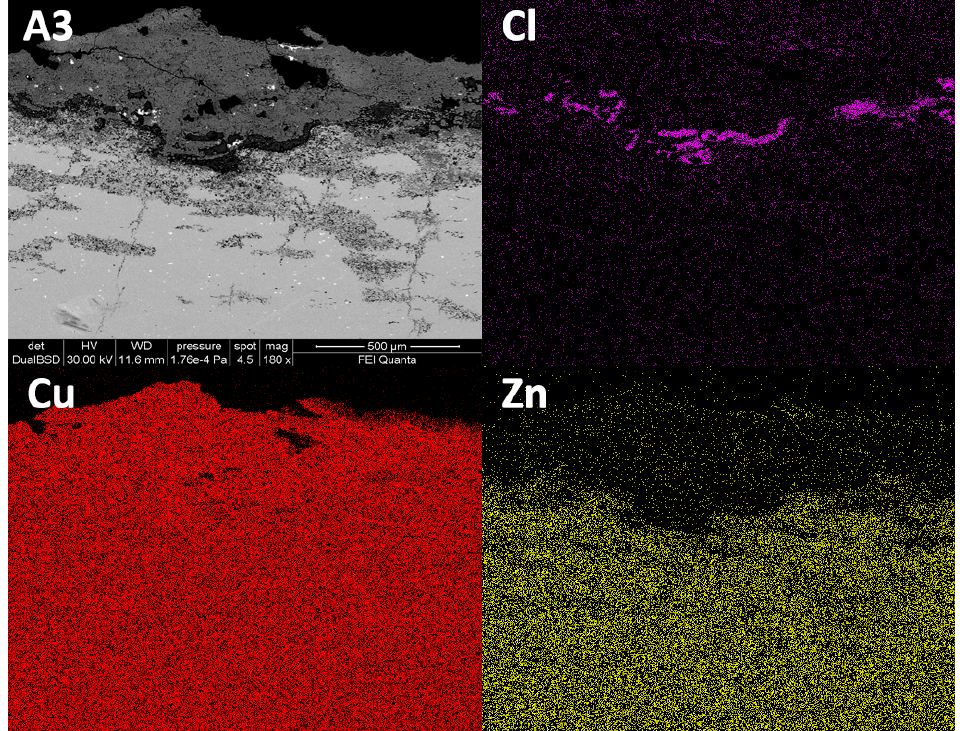
Figure 5. BSE images in cross section of sample A3 and related X-ray maps of Cl, Cu and Zn. The maps highlighted the presence of Cl at the interface between the patina and the unaltered core, as well as the dezincification of the outer layer of the coin A3.